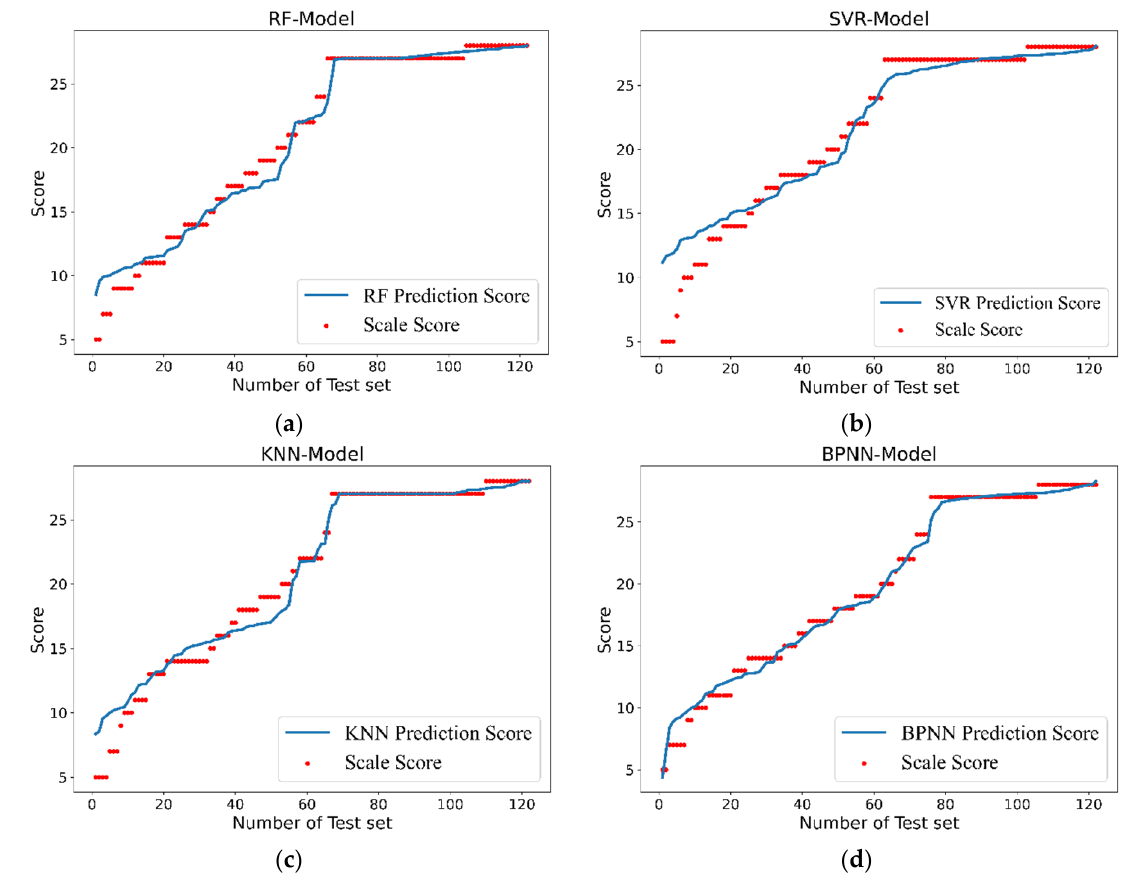
Figure 7. Comparison of the prediction score of the four evaluation models with the doctor’s scale score. ( a ) RF-Model, ( b ) SVR-Model, ( c ) KNN-Model, and ( d ) BPNN-Model. score. ( a ) RF-Model, ( b ) SVR-Model, ( c ) KNN-Model, and ( d )